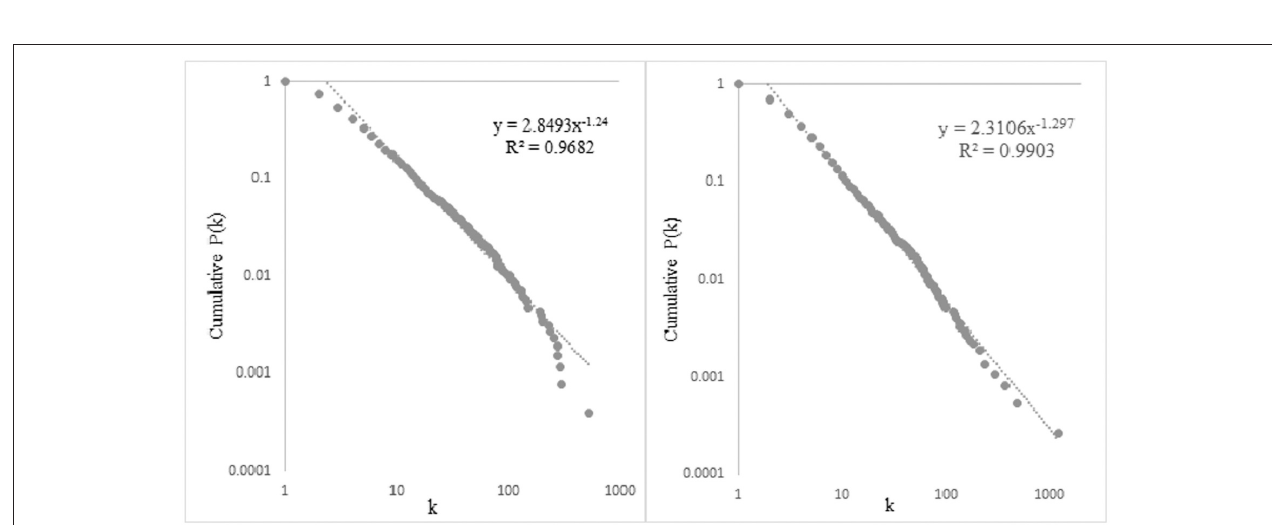
FIGURE 6 | The cumulative degree distributions of the syntactic dependency networks of the DHHs (left) and the NHs (right).